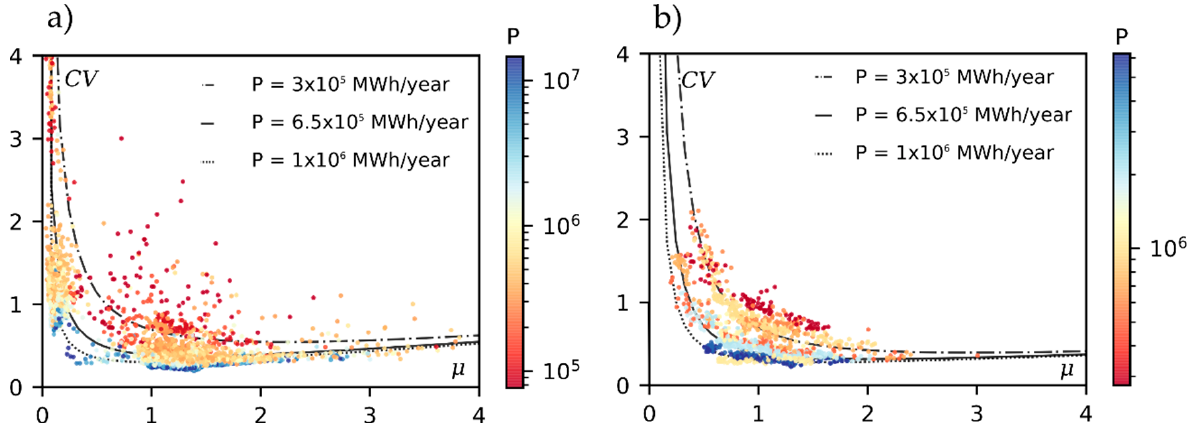
Figure 5. 𝜇 - 𝐶𝑉 relationship of the daily heat load pattern ( 𝑤 (cid:3031) ) with parameter P for the two considered groups (( a ) group 1, ( b ) group 2); the dots show the real data values and their colour the corresponding parameter P (colormap), while the lines indicate the results of Equation (11) with the parameters P as indicated in the legend.